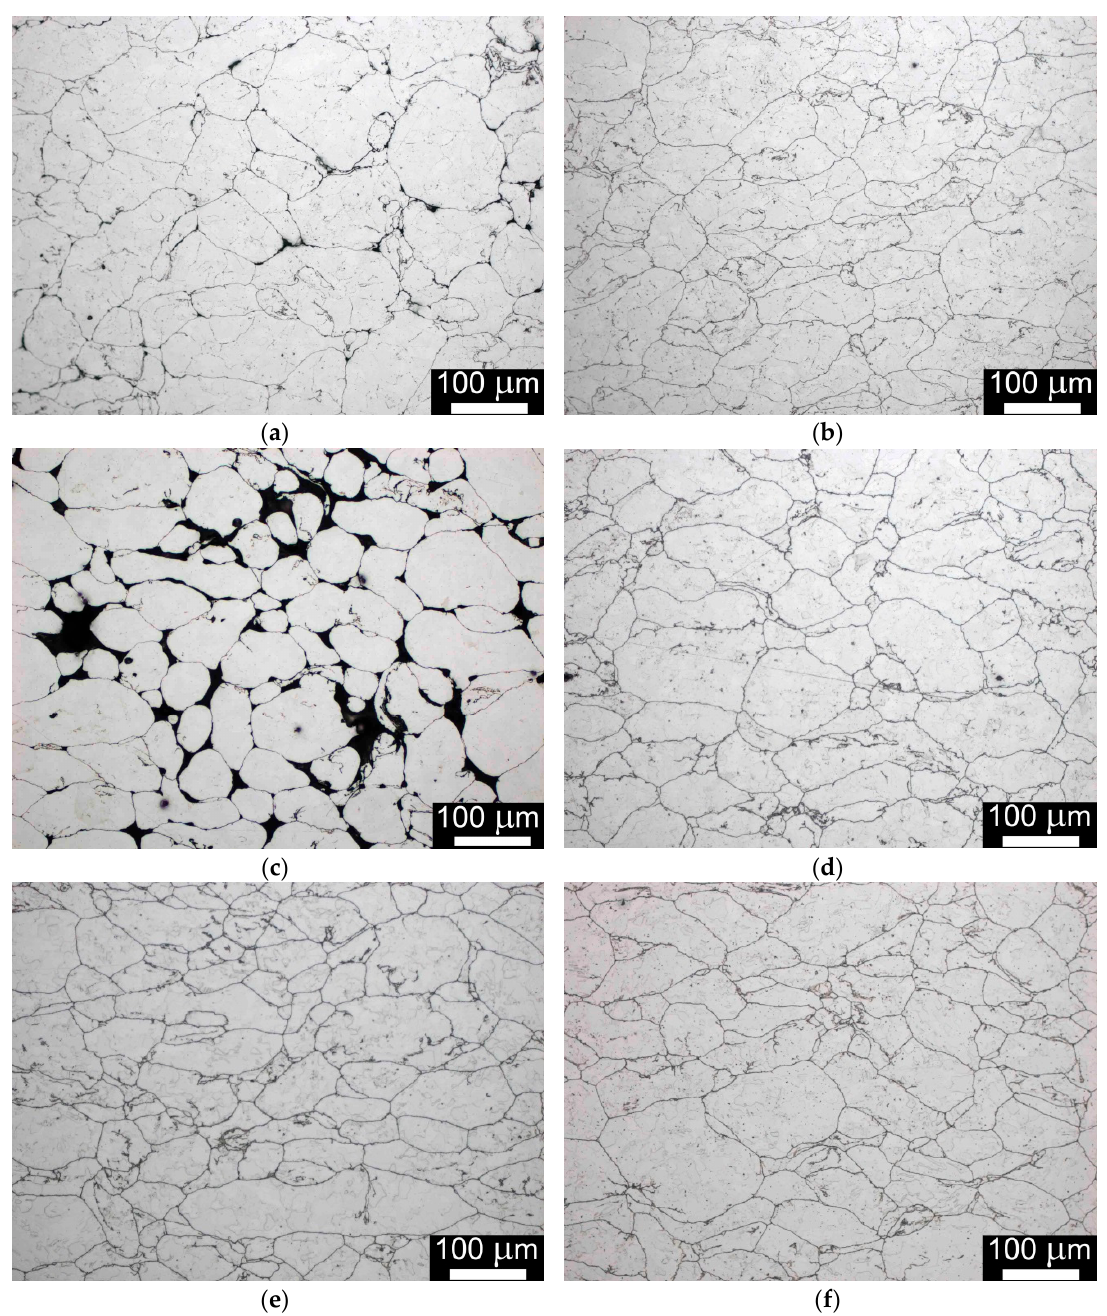
Figure 3. Microstructure of materials prepared from Zn150 powder, etched with 5% Nital, OM: ( a ) 100 MPa, CP; ( b ) 500 MPa, CP; ( c ) 100 MPa, CP-S; ( d ) 500 MPa, CP-S; ( e ) 100 MPa, HP; ( f ) 500 MPa, HP.